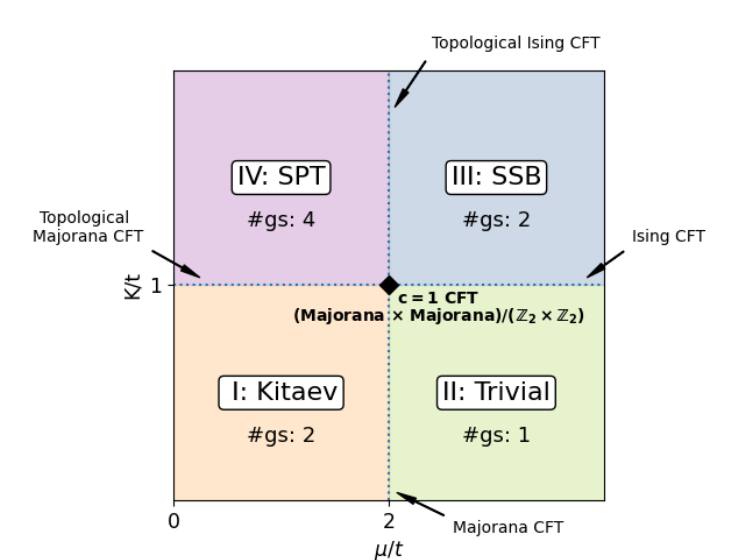
Figure 4: The phase diagram for the Hamiltonian (35) at h = 0. The transition lines are straight, as a consequence of two exact dualities explained in the main text. The intersection point (solid) corresponds to a conformal field theory with central charge c = 1. Ground state degeneracy in open chain geometry for each phase is also presented. The limit K → 0 corresponds to the ordinary Kitaev chain (1) whereas K → + ∞ is the gauged Kitaev chain (14) studied in section